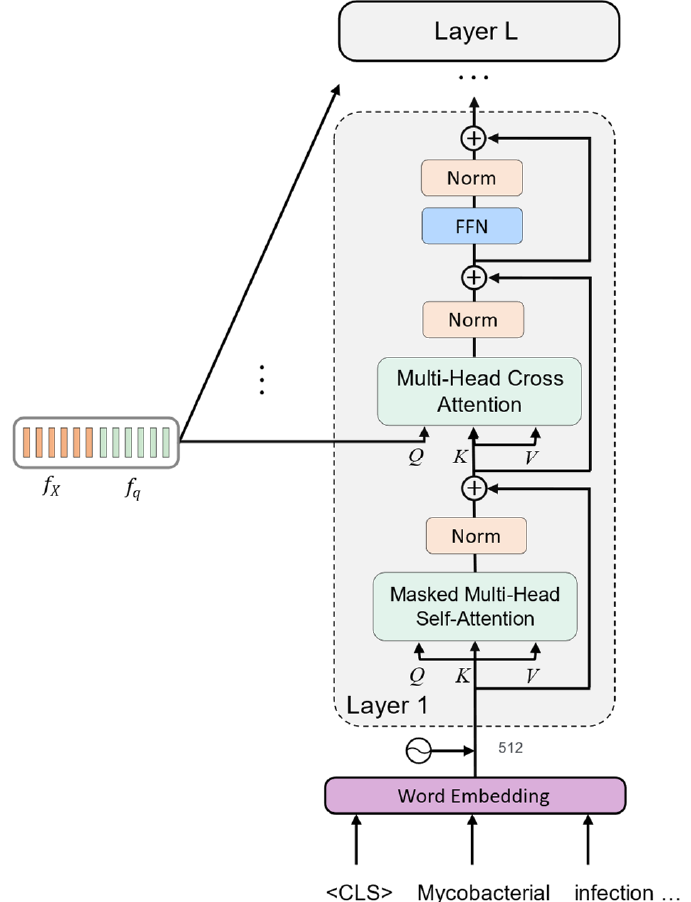
Figure 4. The architecture of the answer decoder.